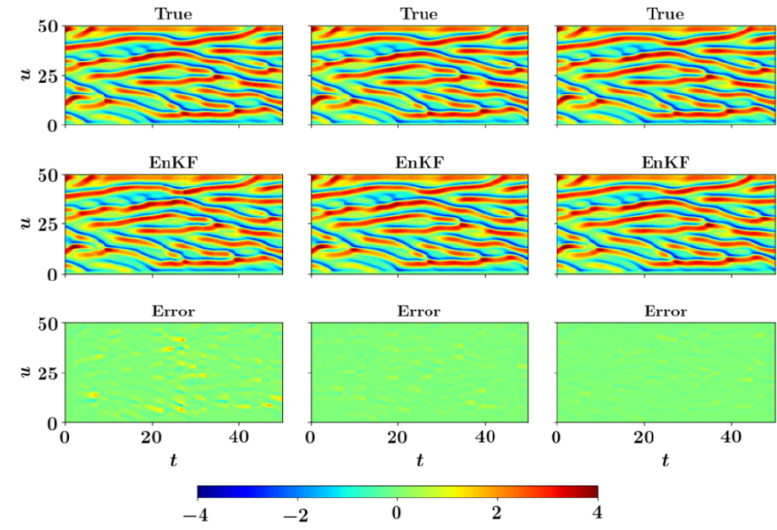
Figure 12. Full state trajectory of the Kuramoto–Sivashinsky model ( ν = 1/2) with the analysis performed by the ensemble Kalman filter (EnKF) using observations from m = 16 ( left ), m = 32 ( middle ), and m = 64 ( right ) state variables at every 10 time